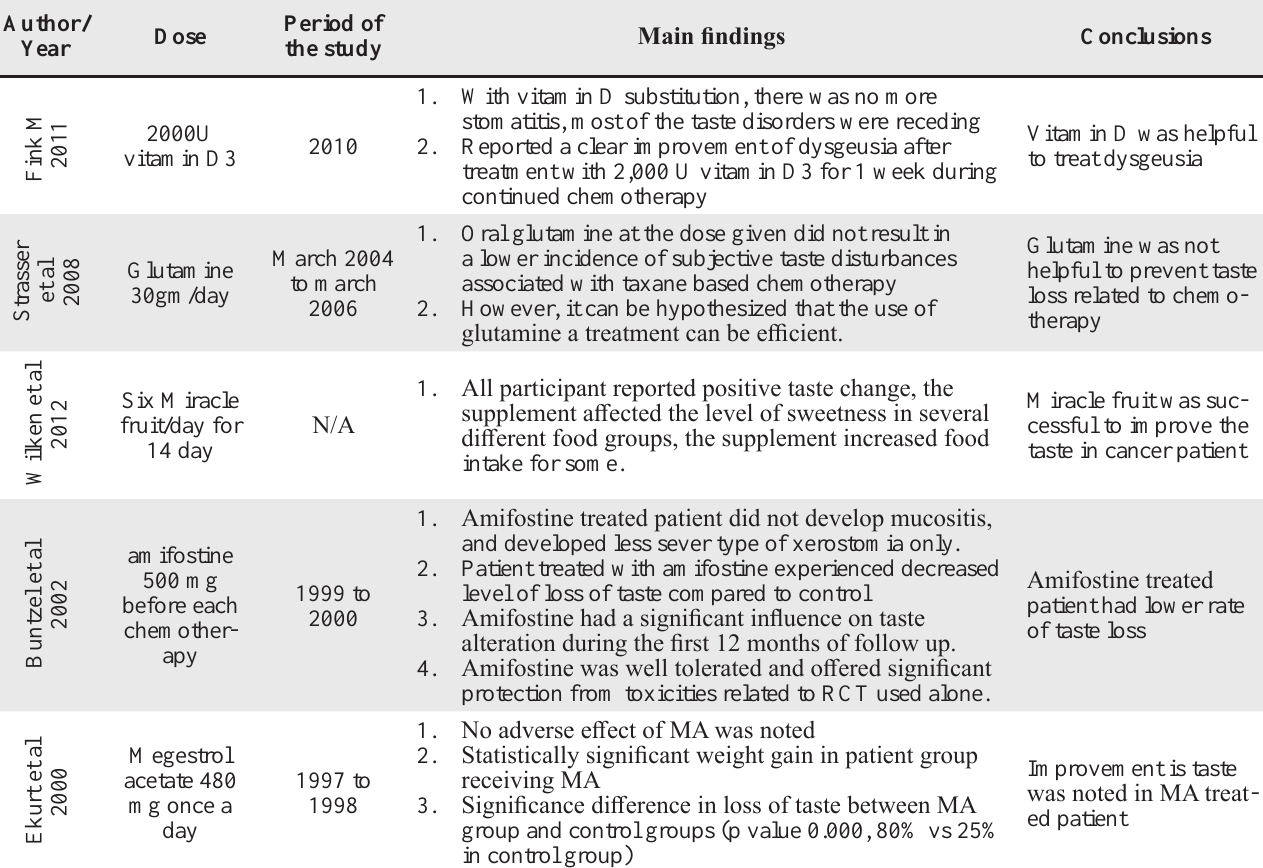
Table 4 : Summary of studies investigating use of other supplement to prevent taste alteration related to cancer and its